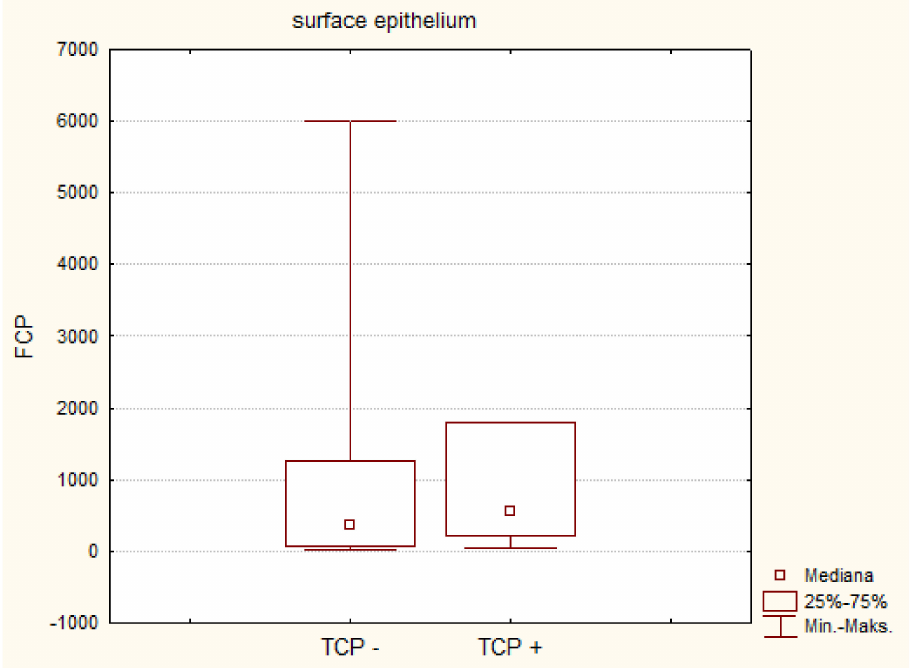
Figure 4. PCDAI and the surface TCP in 57 patients; the lower the PCDAI (milder disease), the higher the TCP in